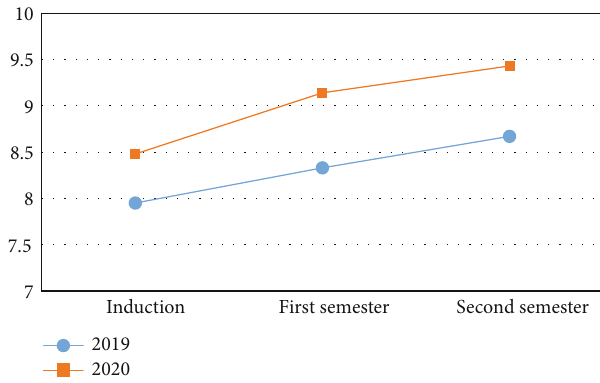
Figure 4: Comparison of student aerobic referee scores and opinions of